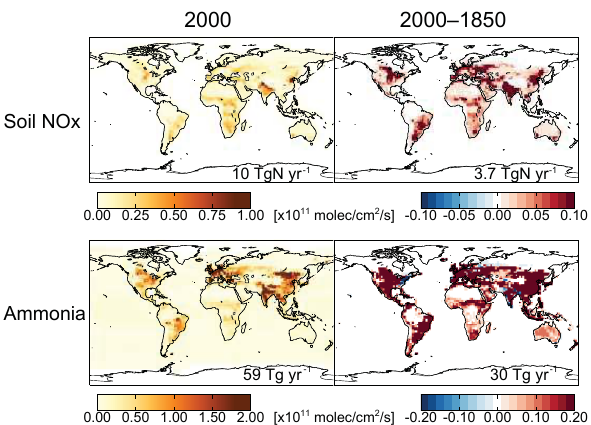
Figure 5. Annual mean emissions of nitrogen oxides from soils (top row) and ammonia (bottom). Total emissions for present day (2000) shown on the left; the change due to historical land use change (and the associated agricultural emissions) is shown on the right. Global annual emission values are shown inset.